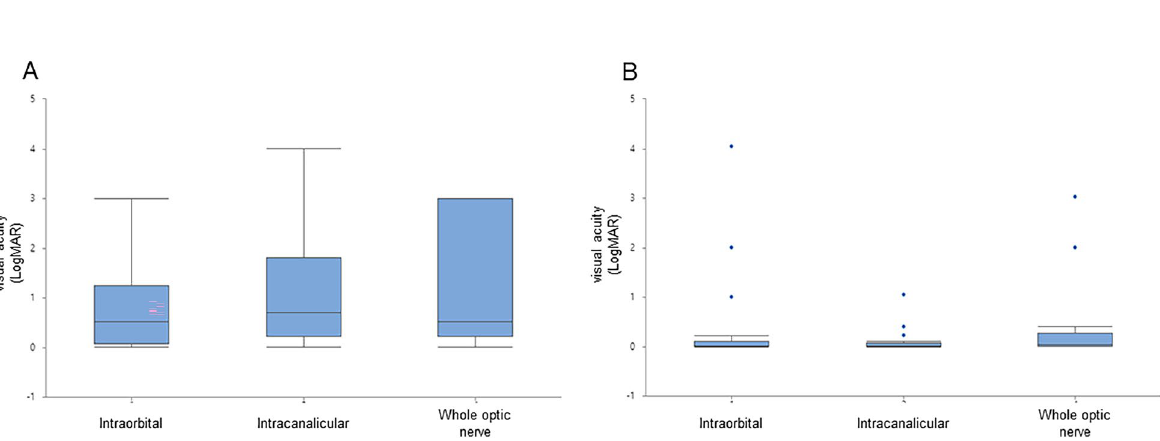
Figure 2. Visual acuity depending on the location of lesions on MRI. ( A ) visual acuity at initial visit (intraorbital; 0.83 ± 0.16, intracanalicular; 1.18 ± 0.27 and whole optic nerve; 1.15 ± 0.32) ( p = .447). ( B ) Visual acuity at final follow-up (intraorbital; 0.28 ± 0.82, intracanalicular; 0.12 ± 0.25 and whole optic nerve; 0.45 ± 0.94) ( p = .457).